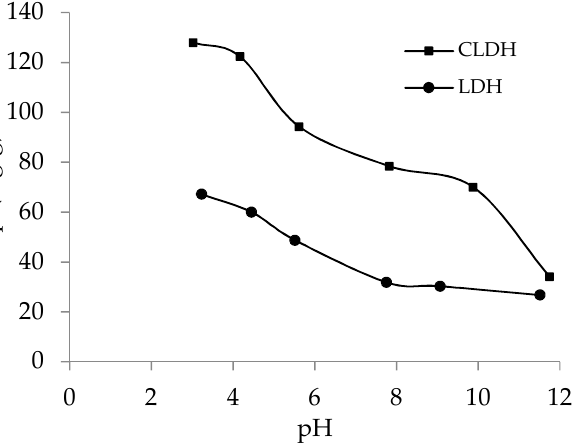
Figure 4. Effect of pH on the adsorption of PBV: C 0 = 15 mg/L, R = 0.1 g/L, agitation time = 2 h, T = 25 °C.